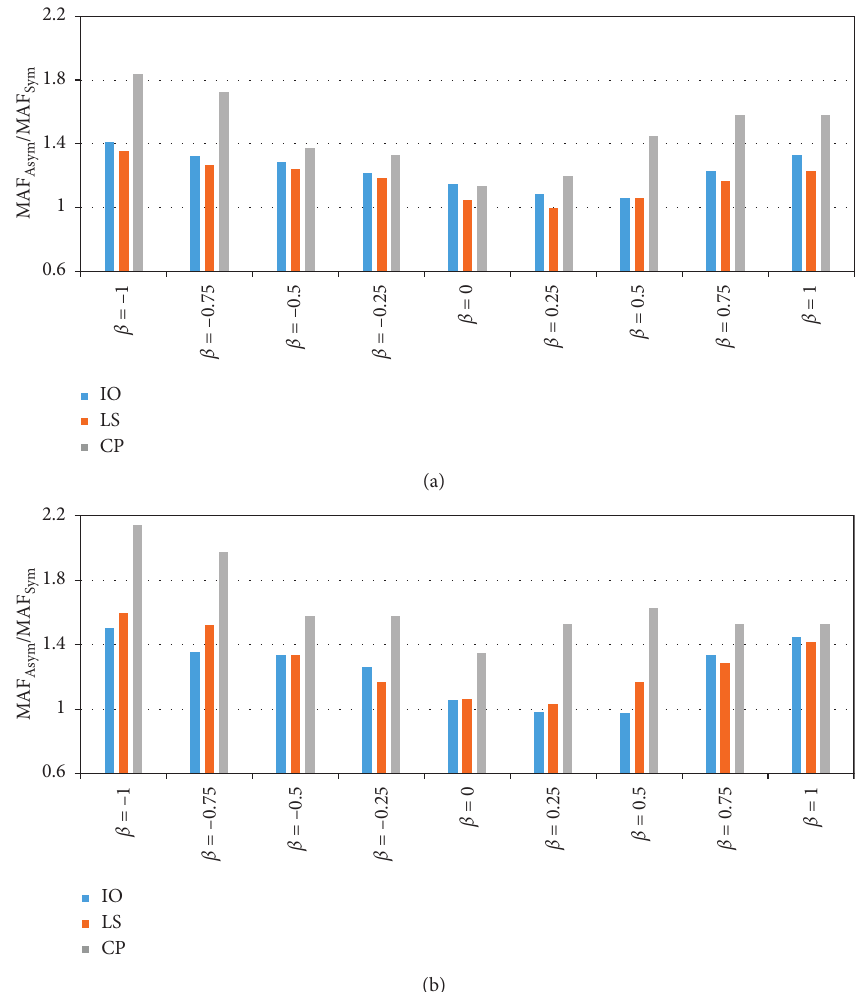
Figure 15: Comparison of the MAFs of the asymmetric models to the symmetric model: (a) fixed base; (b) flexible base.